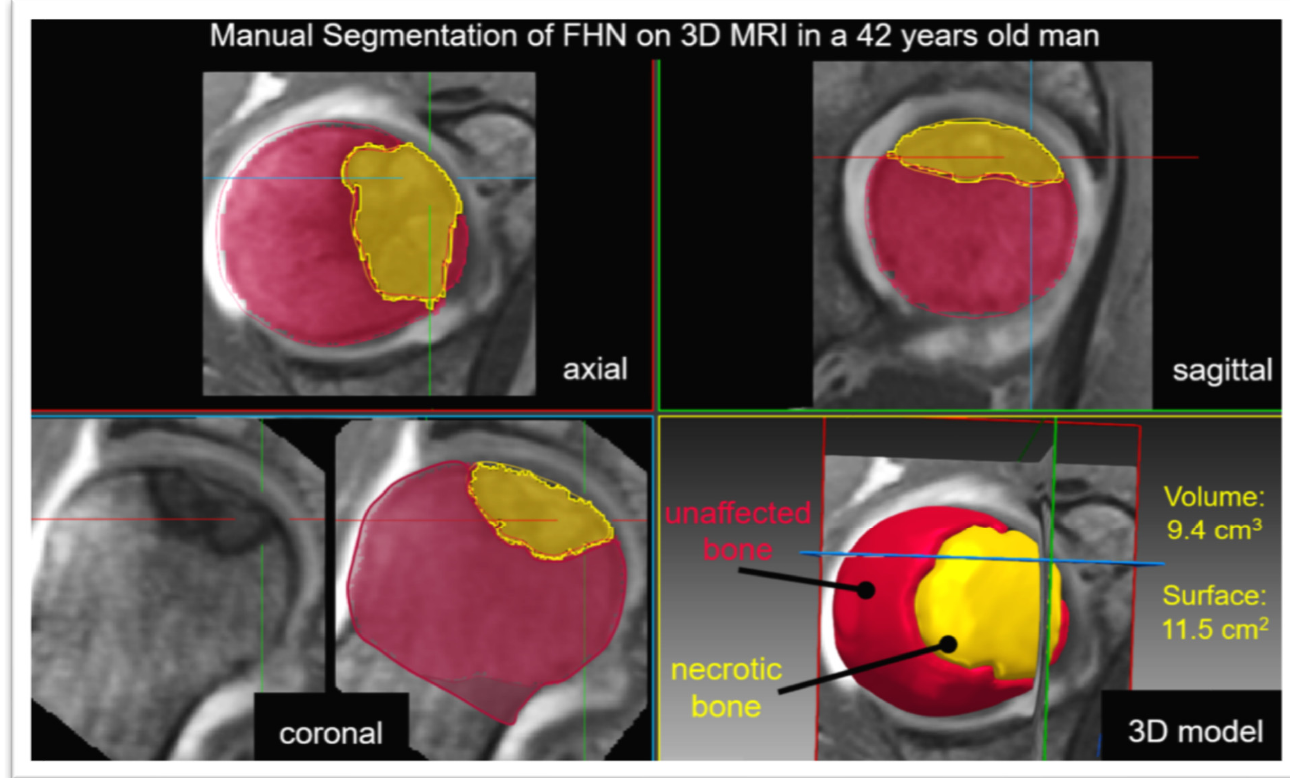
Figure 1. Manual segmentation of femoral head necrosis based on the 3D T1 volume interpolated breath-hold examination (VIBE) sequence is shown. The 3D sequence allows for multiplanar reformation for the threshold assisted 3D segmentation of the unaffected bone (red) and the necrotic bone (yellow). In this patient, this yielded a necrotic volume of 9.4 cm 3 and surface area of 11.5 cm 2 . Images were volume-cropped with a spacing of 160 × 30 × 160 voxels and 0.44 × 2.4 × 0.44